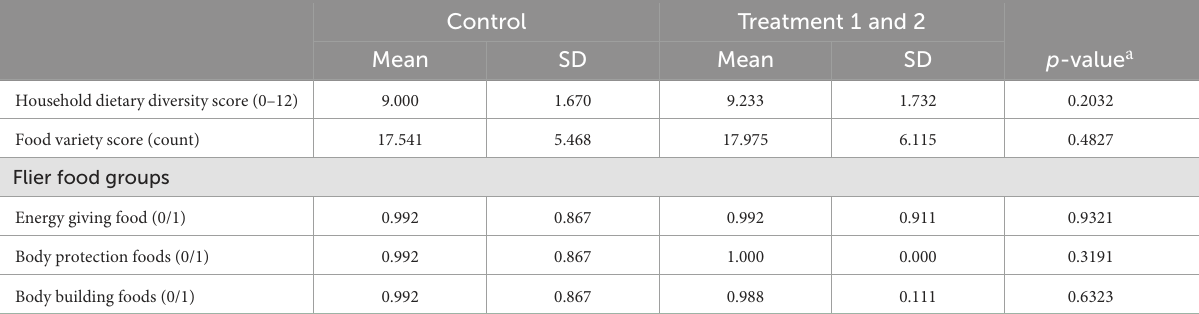
TABLE 4 Descriptive statistics of nutritional indicators comparing control and treatment groups in December survey (post